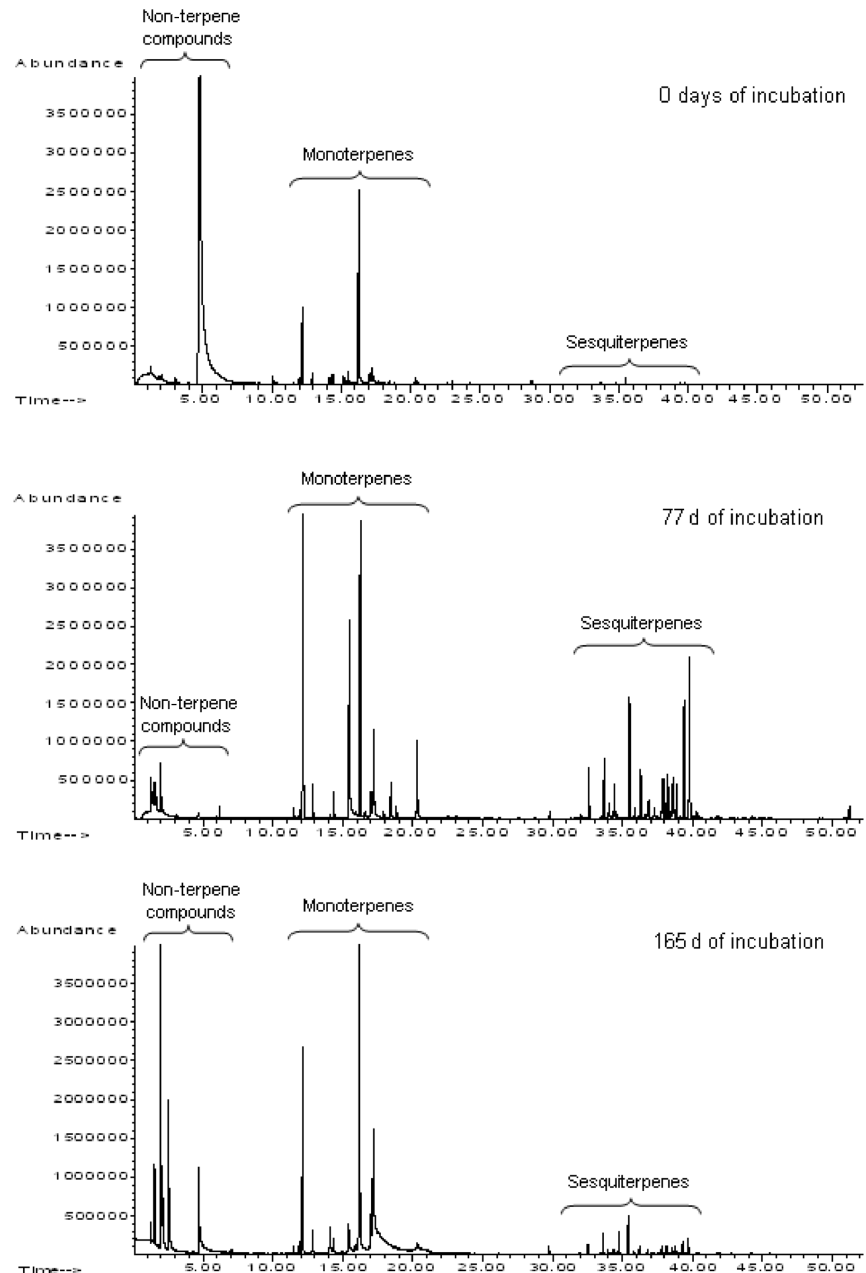
Figure 2. Changes in the profiles of volatile emissions of pine litter at the first stages of decomposition in natural conditions. HS-SPME– GC-MS chromatograms from pine needle litter emissions concentrated on polydimethylsiloxane (PDMS) fibre (Isidorov et al.,